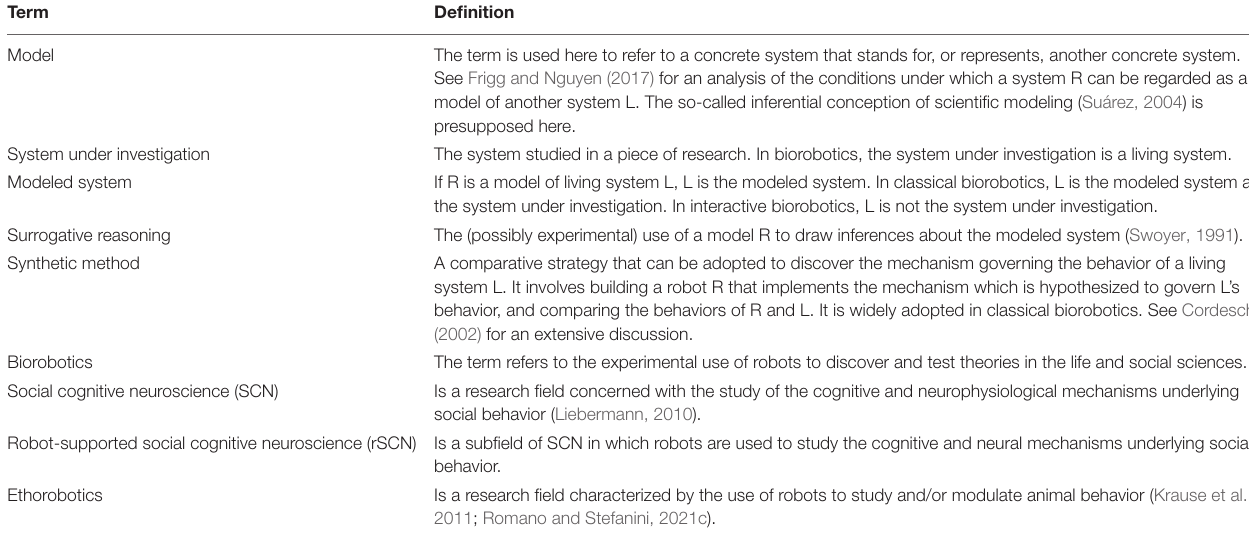
TABLE 2 | Definitions of the key terms used in the